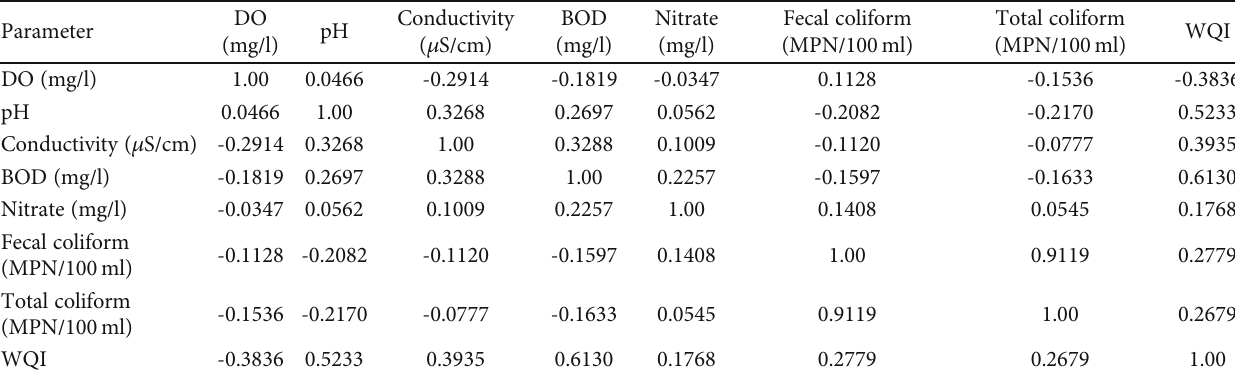
Figure 9: Regression plot of the LSTM model. Table 7: Performance of Pearson ’ s correlation coe ffi cient